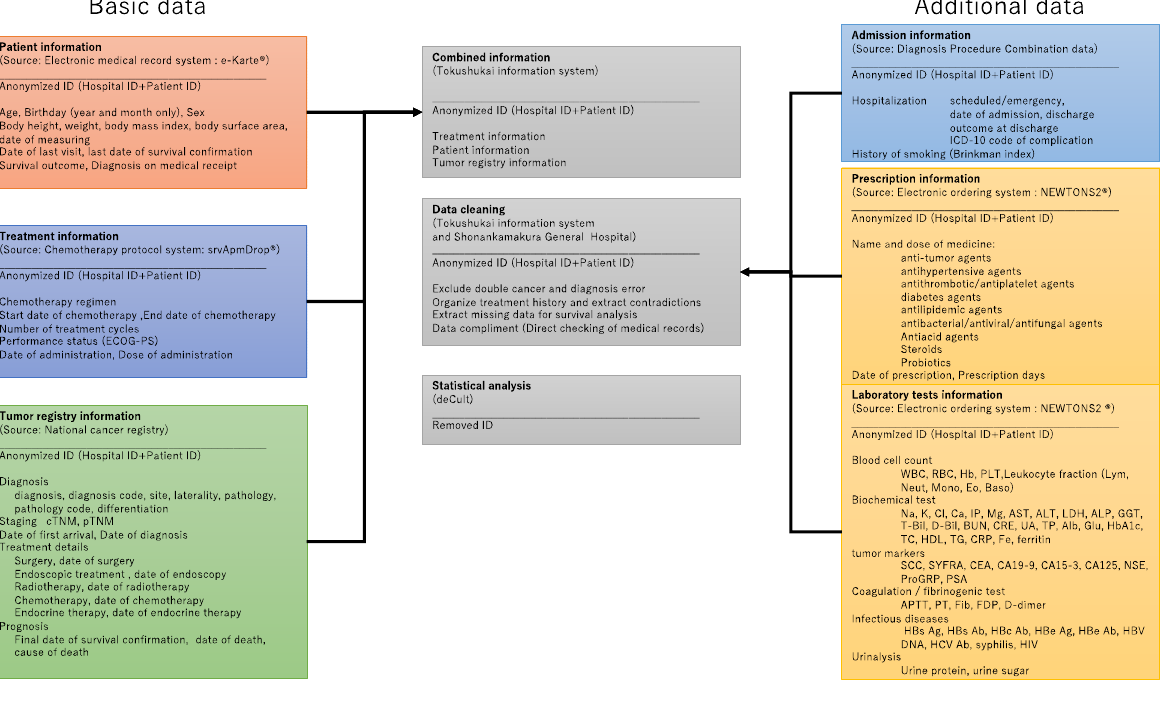
Figure 1. Data collection overview .